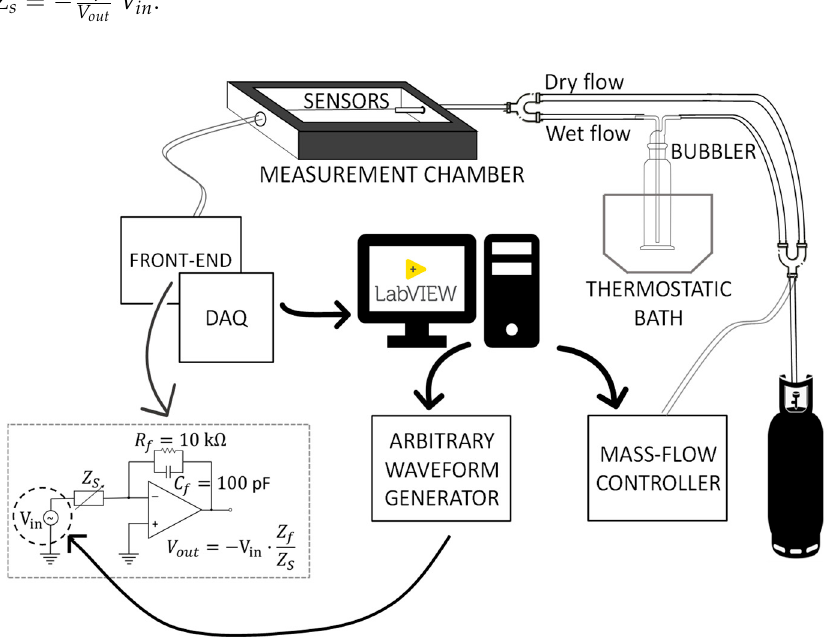
Figure 2. Measurement system block diagram.